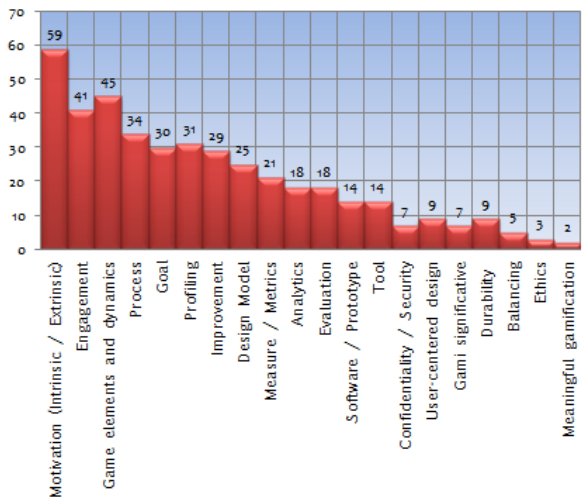
Figure 3 :Gamification design